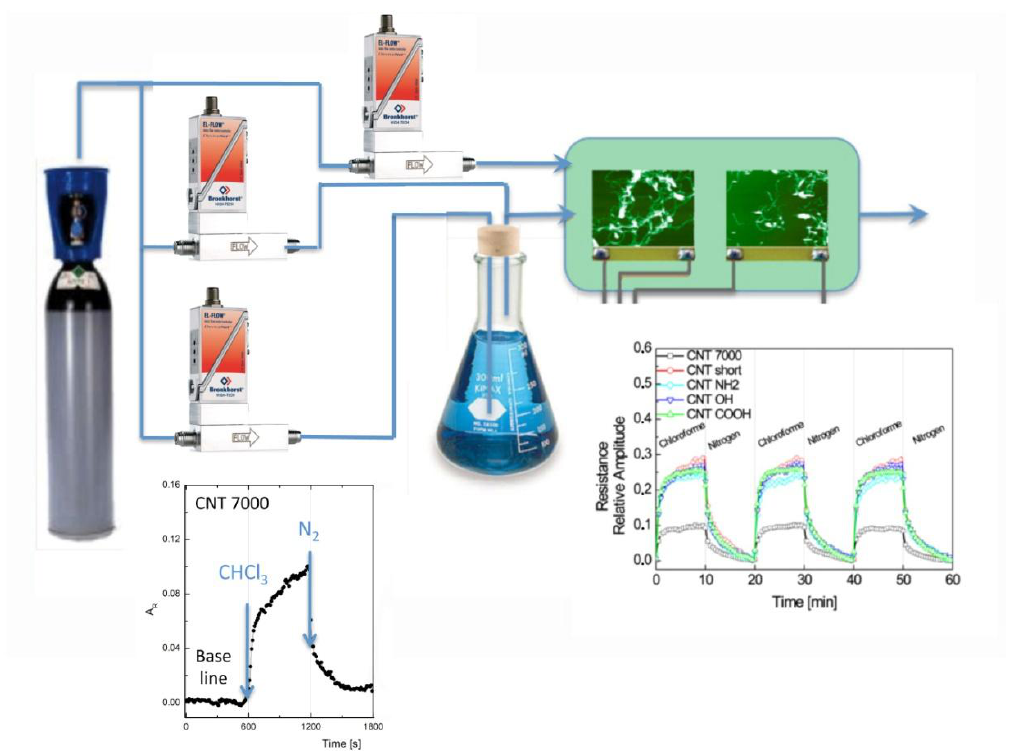
Figure 2. Scheme of the dynamic vapor sensing device, transducers and typical responses of CNT 7000 ( left ) and functionalized CNT ( right ) to chloroform vapor